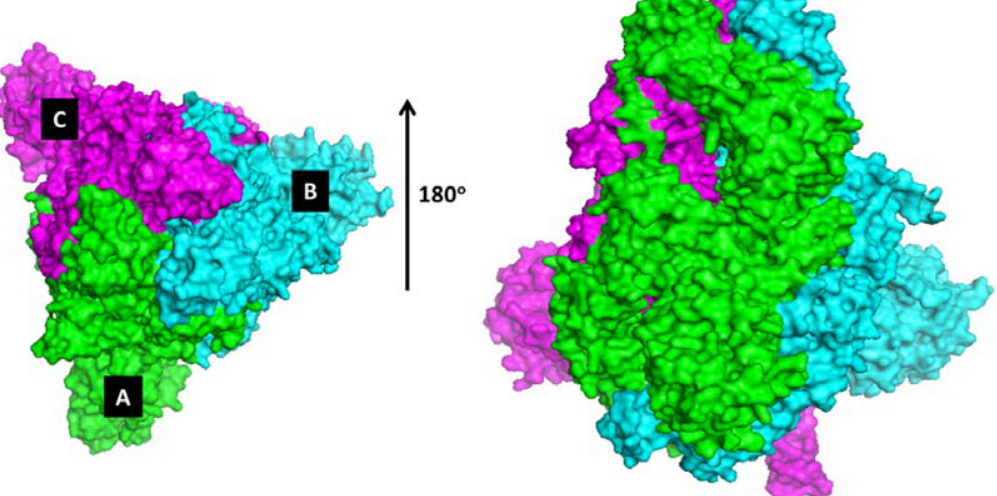
Fig. 1. 3D model of SARS-CoV-2 spike glycoprotein. Protein structure consists of A (green), B (cyans), and C (magenta)